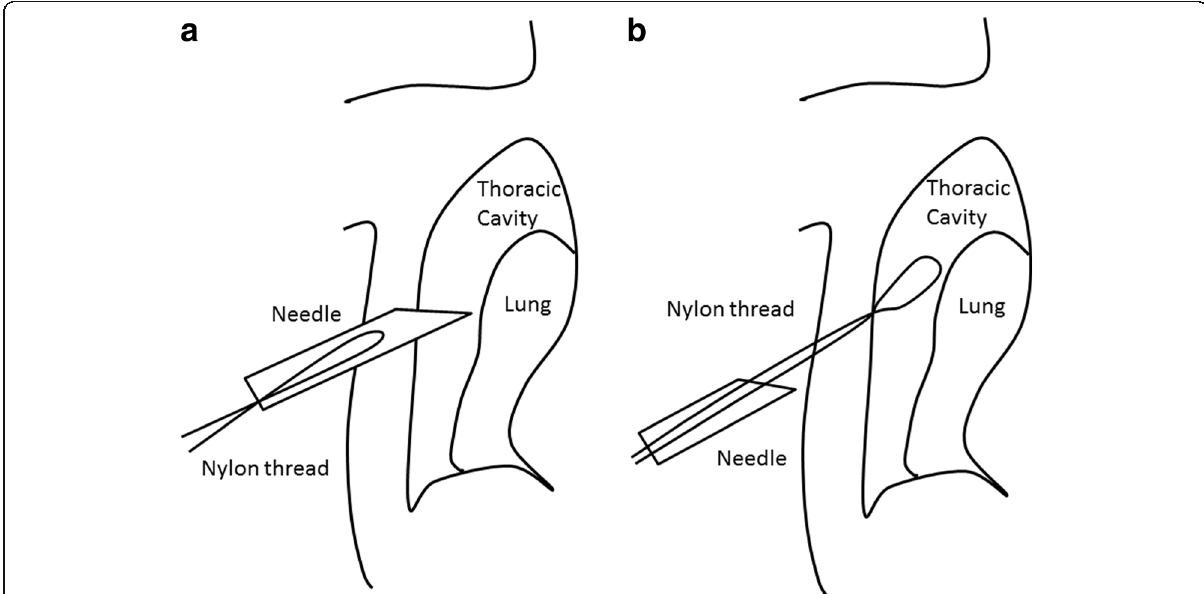
Fig. 3 The schema described how to introduce the looped nylon into the thoracic cavity through the needle. a The looped nylon thread is kept inside the needle during piecing of the chest wall. b The looped nylon is pushed into the thoracic cavity, and then the needle is